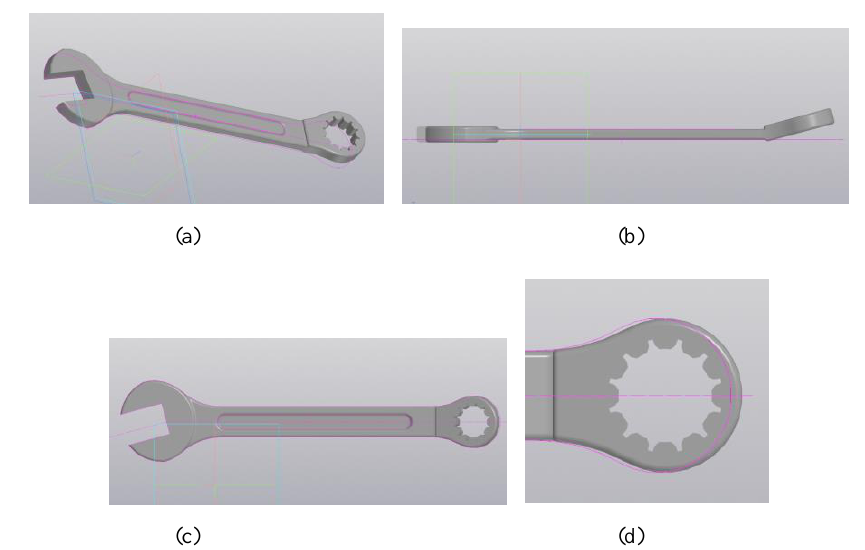
Fig. 2 . A three-dimensional model of the key constructed using sketches. (A 3D key model built using sketches.) (a) General view, (b) Side view, (c) Main type, (d) Element. The model uses a sheet body for ease of bending (a-b). The volume was created using various methods of extrusion, such functions as mirror array and plane offset were used to build the protruding parts of the key.